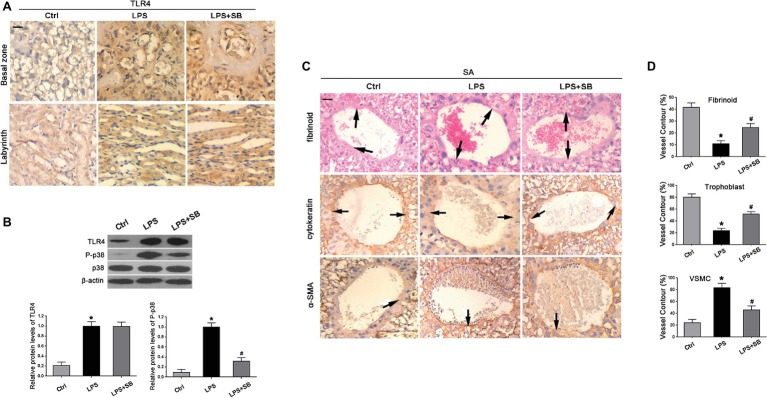
Expressions of TLR4 and p-p38 and their effects on trophoblast invasion and SA remodeling in LPS-treated rats. (A) Immunohistochemistry suggested that TLR4 staining was enhanced in the cytoplasm in LPS-treated and LPS plus p38 inhibitor SB203580-treated rats, which was predominantly expressed by spongiotrophoblast cell, trophoblastic giant cell, and glycogen cell in the basal zone as well as trophoblastic epithelium in the labyrinth of rat placenta. Scale bar = 100 μm. (B) Western blot revealed that LPS treatment gave rise to TLR4 expression and p38 phosphorylation in the placenta of pregnant rats. The addition of SB203580 dramatically abrogated p38 activation, whereas showed little alterations on TLR4 expression. Values denote the mean ± s.d.; *p < 0.01 vs. control, #p < 0.01 vs. LPS-treated group. (C) SAs from all groups exhibited evidence of remodeling, including the endovascular trophoblast cells of cytokeratin staining (arrows) resting on a fibrinoid layer of PAS staining (arrows) and the smooth muscle cells of α-SMA staining (arrows). Scale bar = 100 μm. (D) The percentages of trophoblast, fibrinoid, and VSMC of total SA contour length were determined. Values denote the mean ± s.d.; *p < 0.01 vs. control, #p < 0.05 vs. LPS-treated group. Ctrl, control group; SB, SB203580.